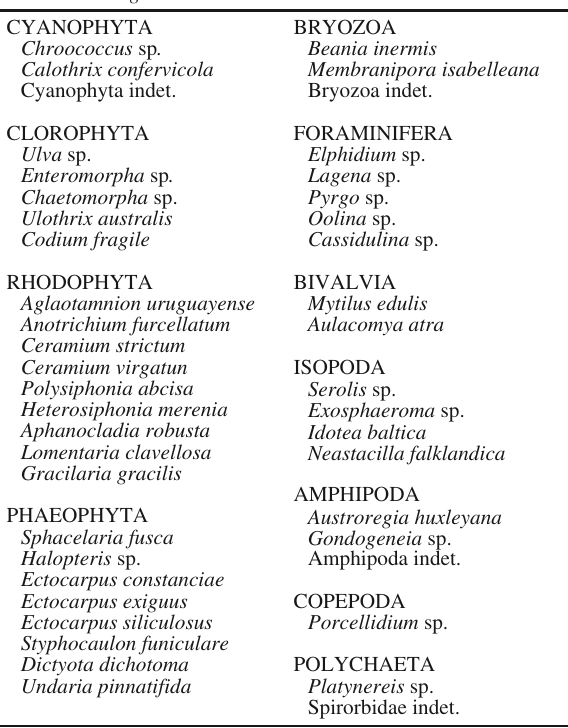
Table 3. – Frequency of occurrence (FO) and relative abundance (RA) of the main food items of L. pentagona in G. gracilis beds of Bahía Food